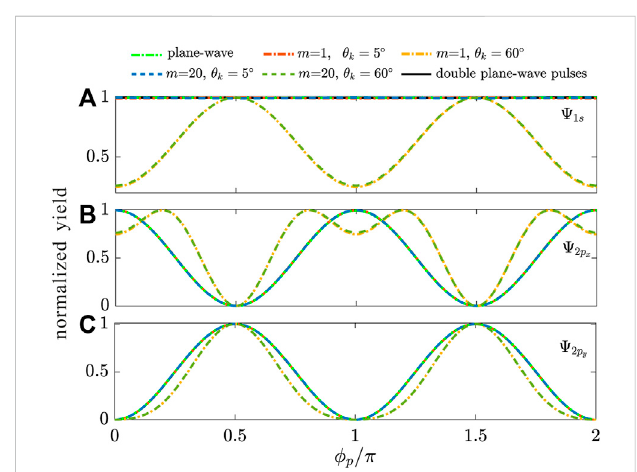
FIGURE 6 Photoelectron angular distributions by integration over the p of electrons emitted from (A) 1 s, (B) 2p x and (C) 2p y states of a hydrogen atom byplane-wave pulse and twisted X wave with m =1, 20 and θ k = 5 ° , 60 ° . The black solid line represents the PAD of double plane-wave pulses with the same time-delay τ as that in Figure 3E. The yield is